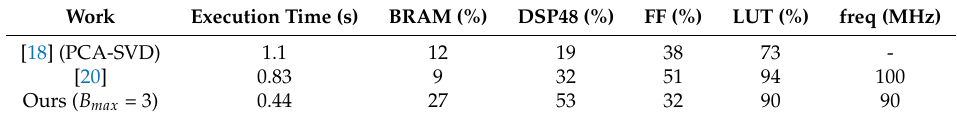
Table 5. Comparison of the proposed PCA hardware design with other High Level Synthesis (HLS)-based accelerators. The dimensions of a spectral image data set (640 × 480 × 12) is selected for all of the designs.